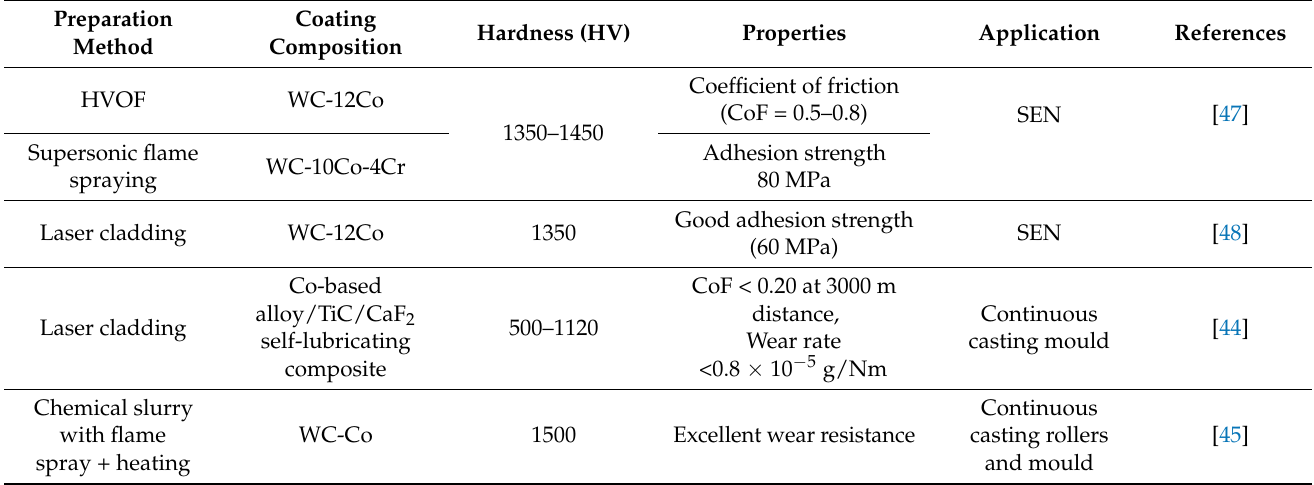
Table 1. Coating composition and process used to develop protective coatings for hardware of an iron and steel making